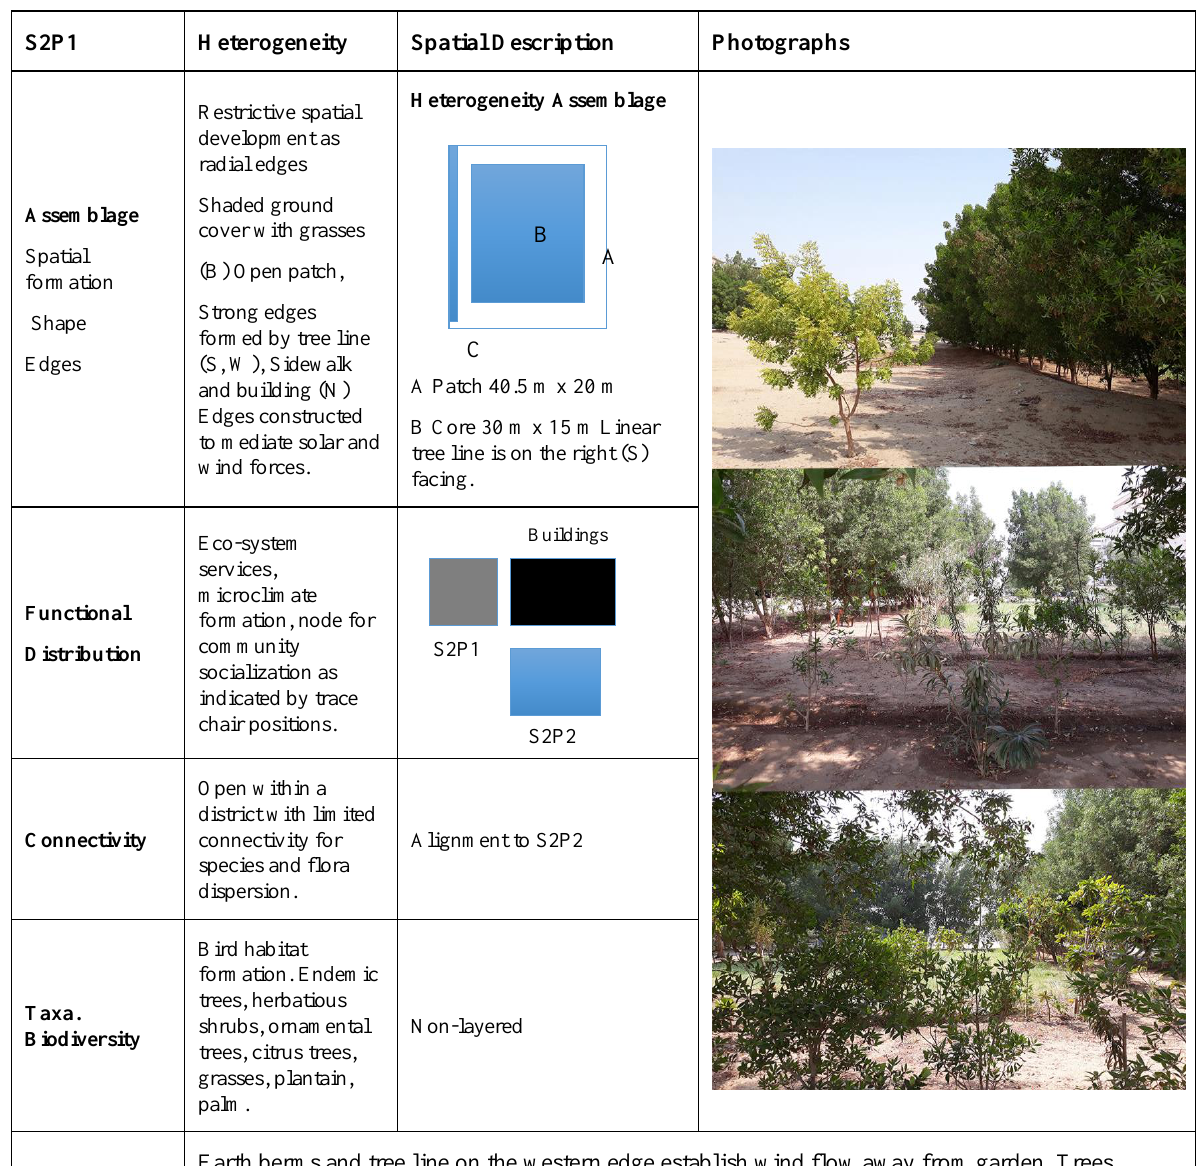
Table 5. Site 2 Patch1 description of habitat